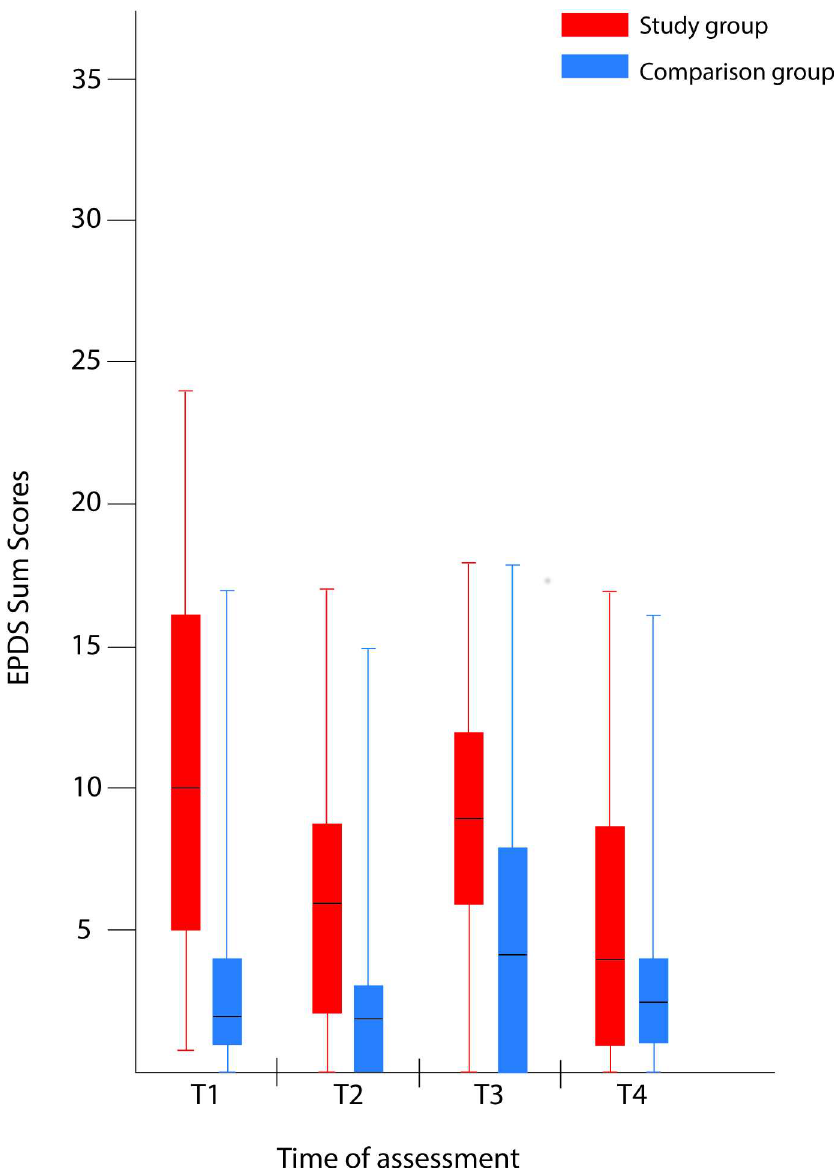
Fig 2. Comparison of maternal psychological distress during pregnancy with and without a fetal anomaly. The figure presents psychologicaldistress in women in the study group (with fetal anomaly)and comparisongroup (normal ultrasound findings)at the four assessments, as measuredby the Edinburgh PostnatalDepressionScale (EPDS). Box-and-whiskers plots show 50% of cases (25–75percentiles) in the rectangle, each of the whiskers represents the smallest and largest values. The line within the rectangle represents the